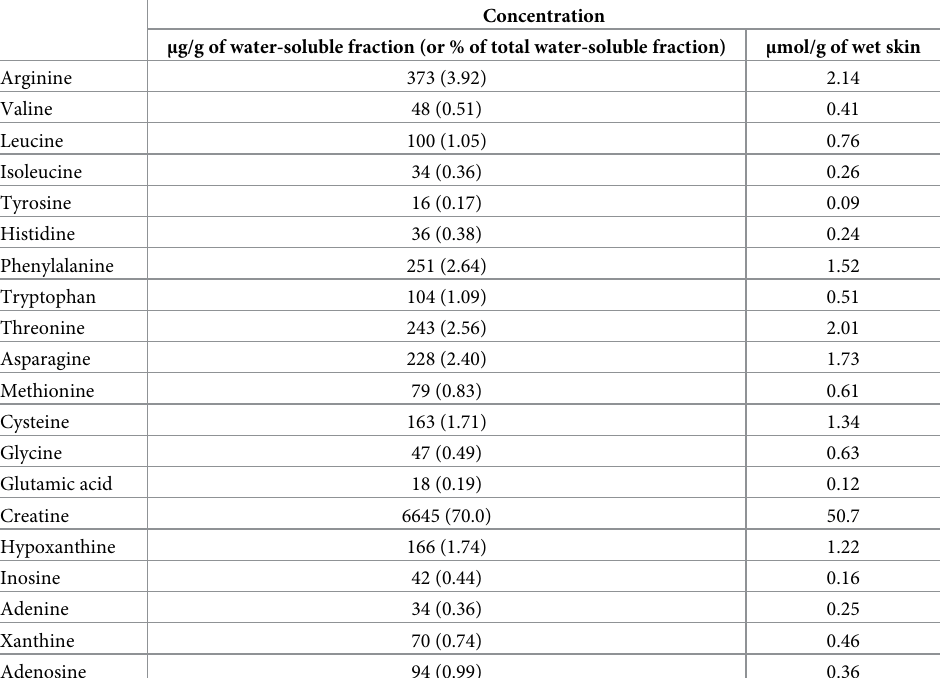
Table 4. Concentration of the nitrogenous compounds isolated from the adult migratory sea lamprey